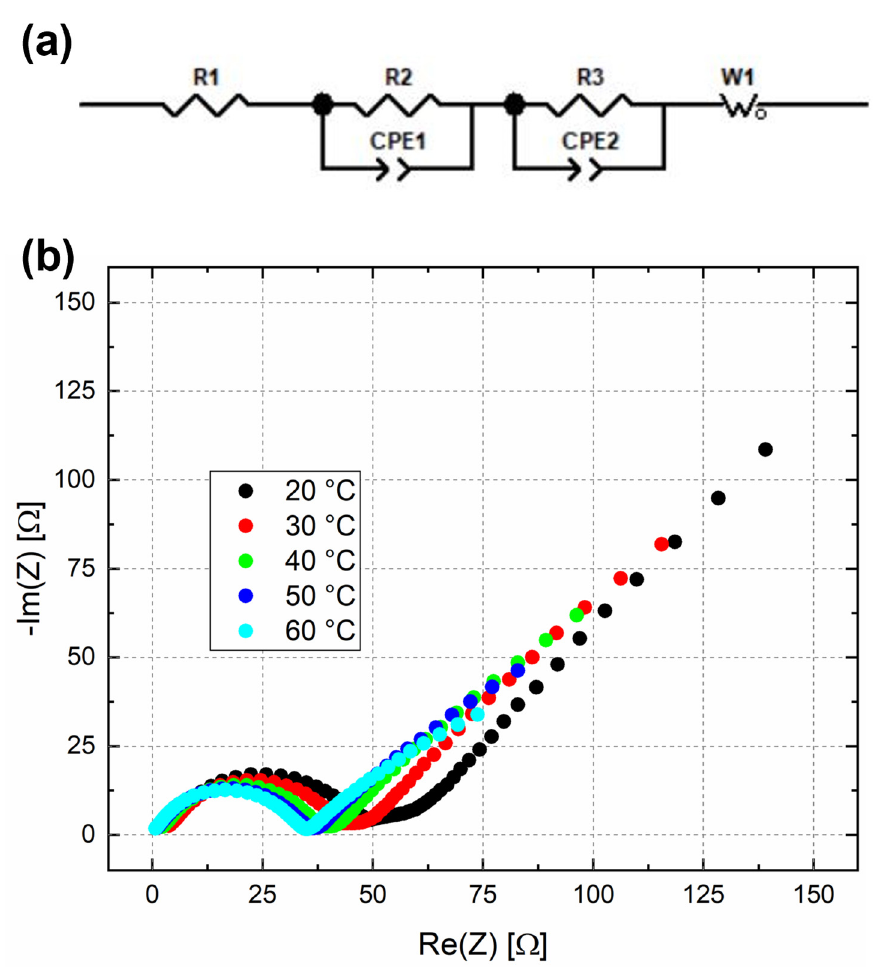
Figure 3. ( a ) The equivalent circuit model used to fit the EIS data; ( b ) impedance spectra at different temperatures for half cell with LFP cathode.